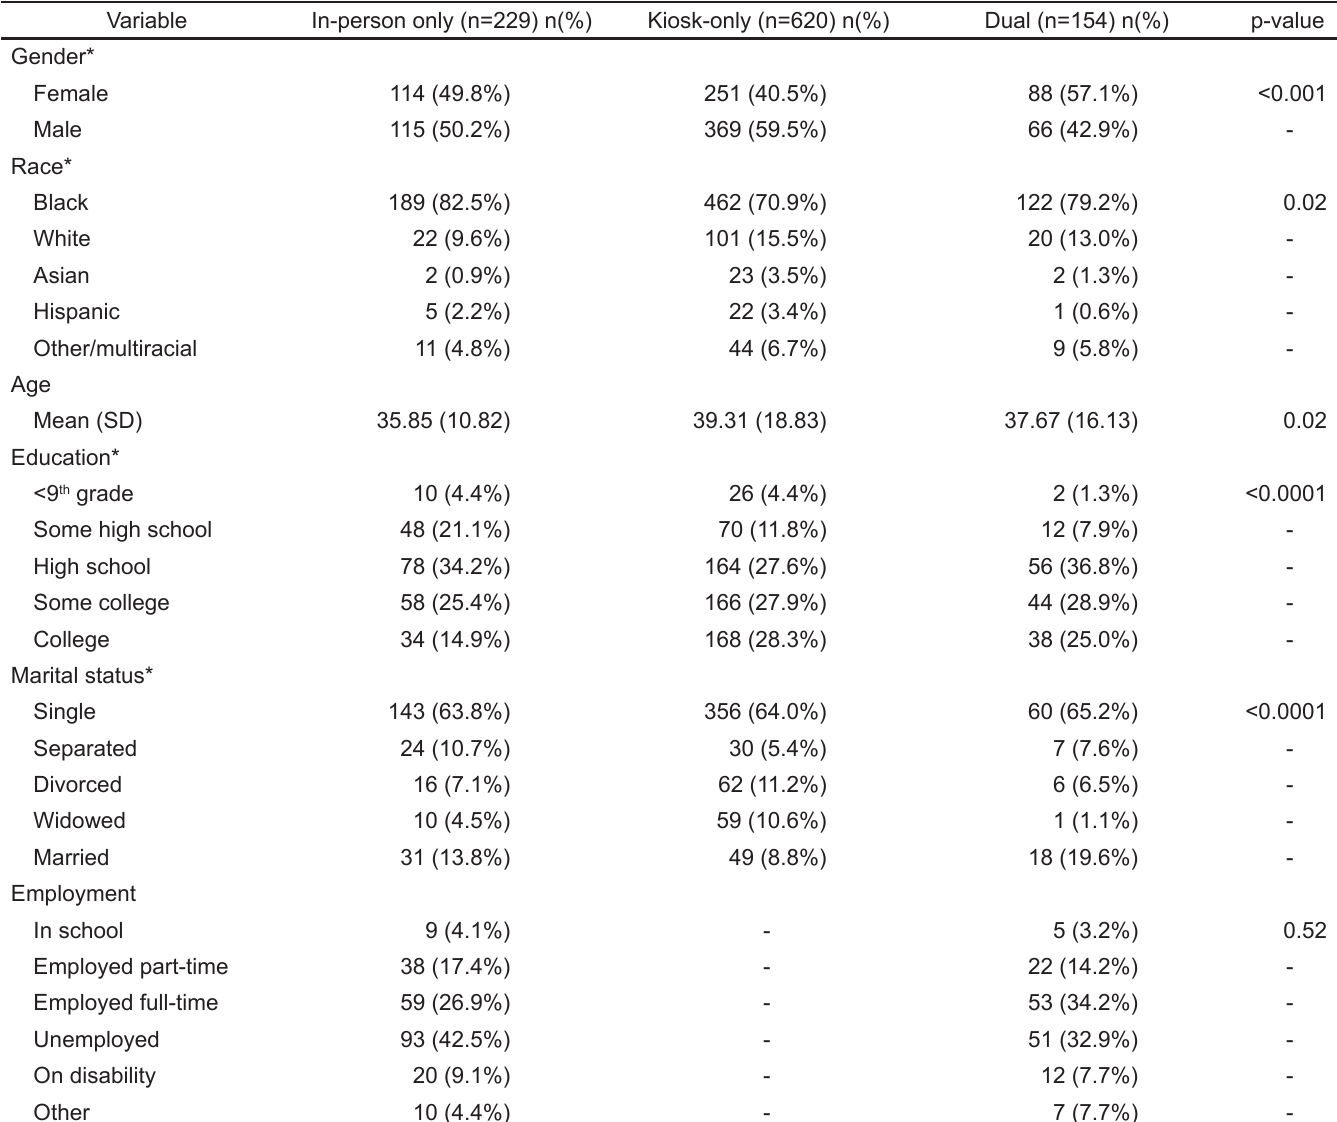
Table 1. Demographic distribution of participants in each alcohol and drug use screening modality